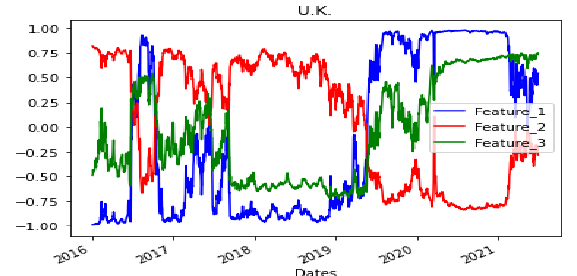
Figure 13. UK AE prediction